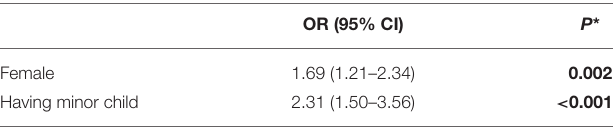
TABLE 2 | Multivariable models showing association between baseline risk factors and anxiety